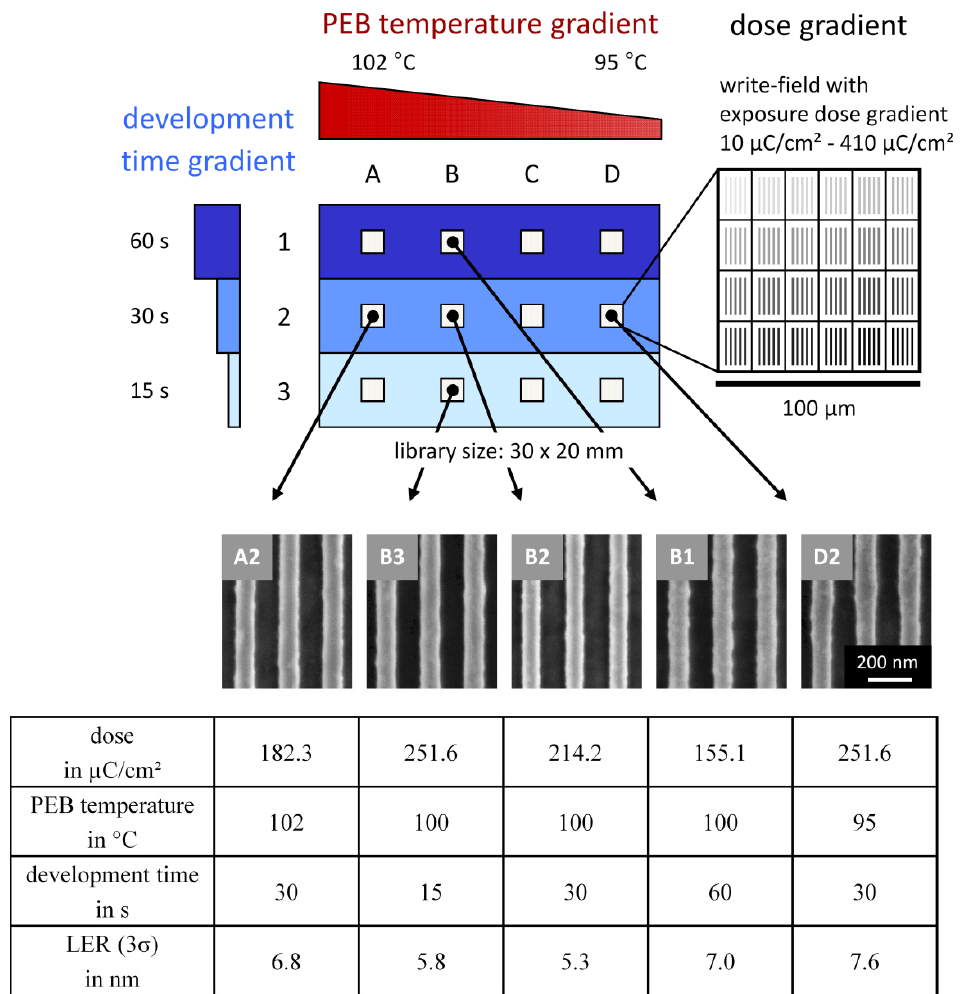
Figure 9. Schematic illustration of the ternary combinatorial library prepared on a substrate with a size of 30 mm × 20 mm. The PEB temperature gradient (95–102 °C) is arranged horizontal and perpendicular to it the development time step gradient (15 s, 30 s, 60 s). The 12 write-fields (100 µm × 100 µm) with the exposure dose gradient (10–410 µC/cm²) are arranged matrix-like in small sectors and provide 24 arrays of 100 nm line/space profiles. The selected SEM images demonstrate the strong influence of the applied three variable gradients. The respective conditions (PEB temperature, development time, and dose plus the LER values) of these patterns are listed